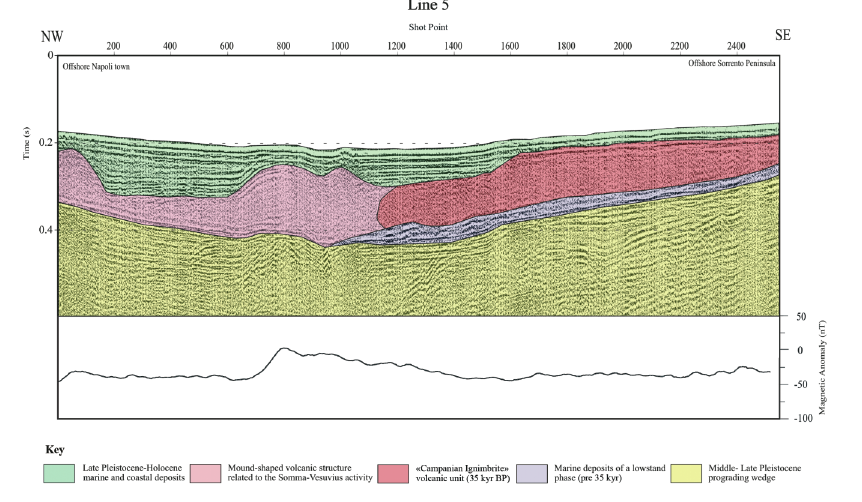
Fig. 5. Seismic profile GR15 and corresponding interpretation. The relative magnetic profile is reported in the inset. Two large, mound-shaped, acoustically-transparent volcanic structures (see the left on the profile) warp the top of a seismic unit correlatable with the Campanian Ignimbrite pyroclastic flow deposits (35 kyr BP). The age of the domes could be very recent, nevertheless they are fossilised by about 300 m of Holocene sediments. A magnetic anomaly with a relative intensity of 40 nT confirms the volcanic nature of these